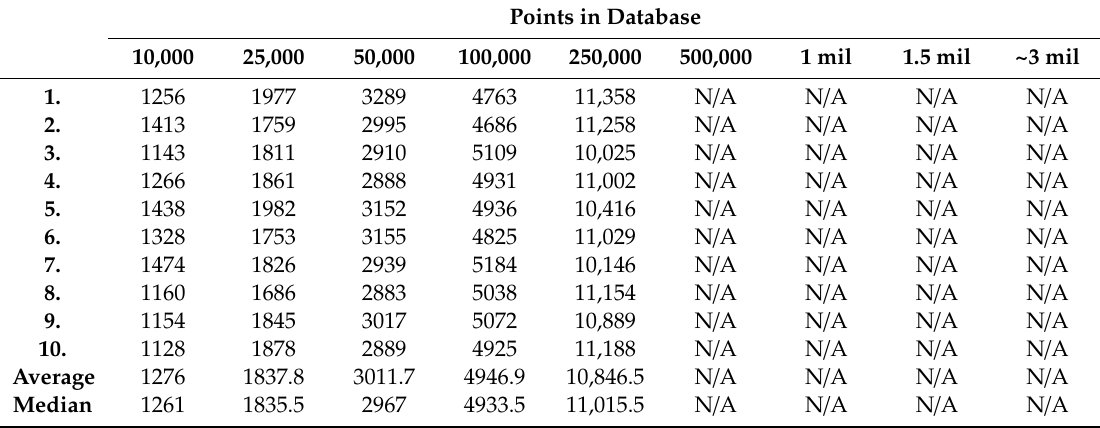
Table 8. Results of testing OpenLayers library (values in milliseconds). Points in